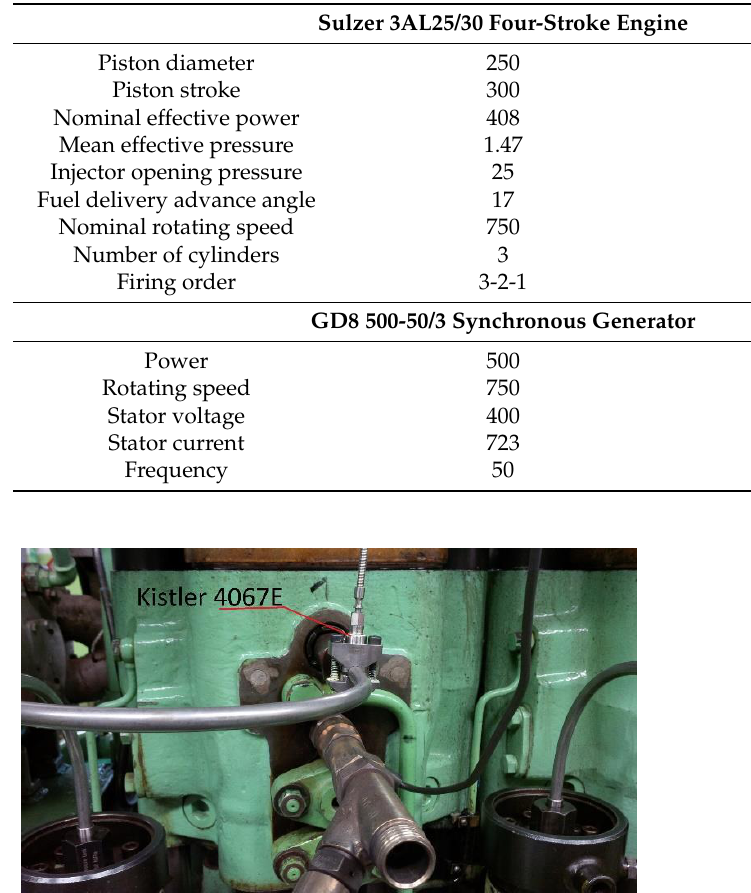
Table 1. Test-stand technical and nominal parameters.